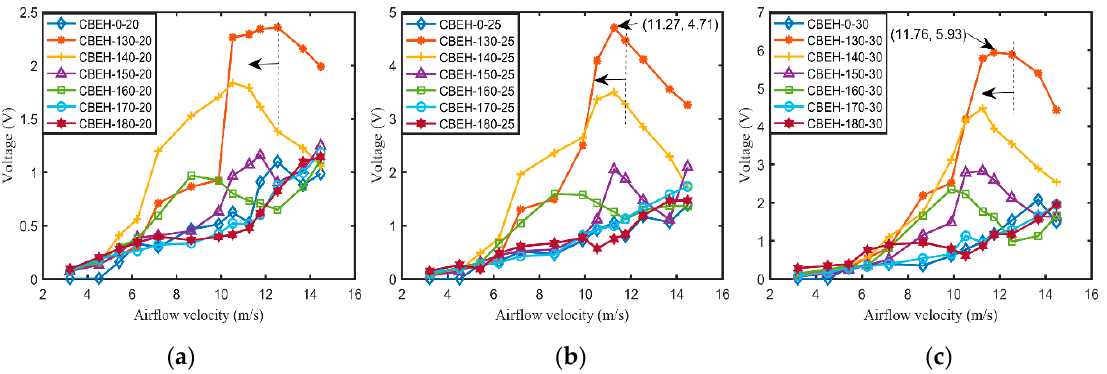
Figure 10. Variation of output voltage with the airflow velocity for the CBEH: ( a ) 20 mm; ( b ) 25 mm; and ( c ) 30 mm.